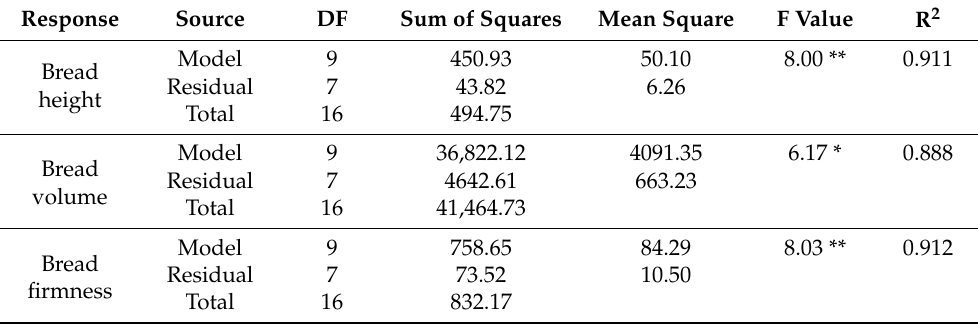
Table 6. Analysis of variance of the quadratic models for height, volume, and firmness of bread